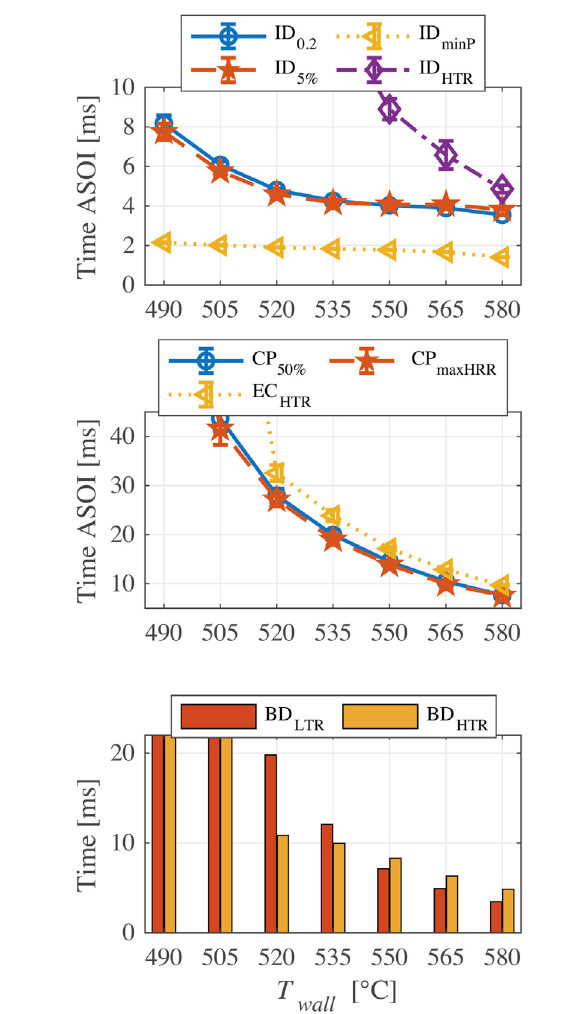
FIGURE 8 | Results of ignition and combustion indicators for FPBO- 30 at different chamber wall temperatures (490 – 580 ° C).